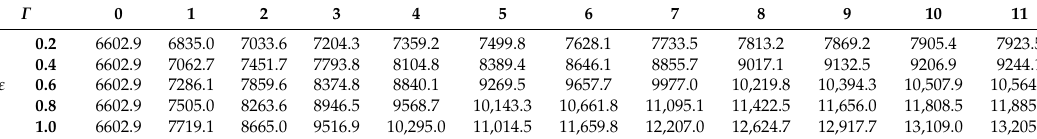
Table 2. Objective values for different ε and Γ ( n = 12).